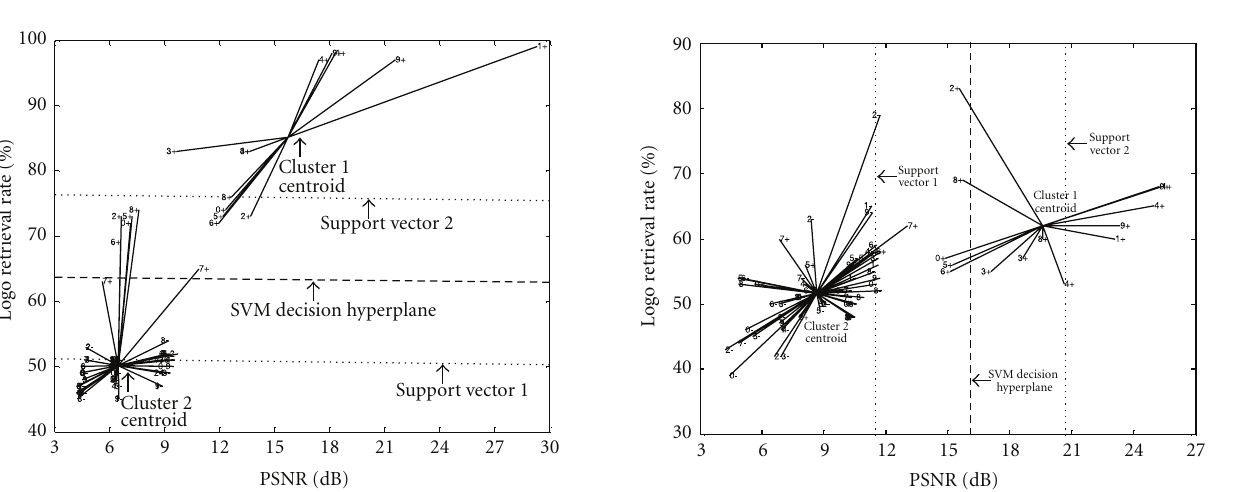
Figure 11: SVM classification and K -means clustering results by the existing VQ-based scheme [13]. Note that the distance between support vectors by SVM [27] is D = 9 . 2 and cluster 1 and cluster 2 are positive and negative clusters, respectively, by K -means clustering algorithm [28]. Attack numbers 0–9 are referred